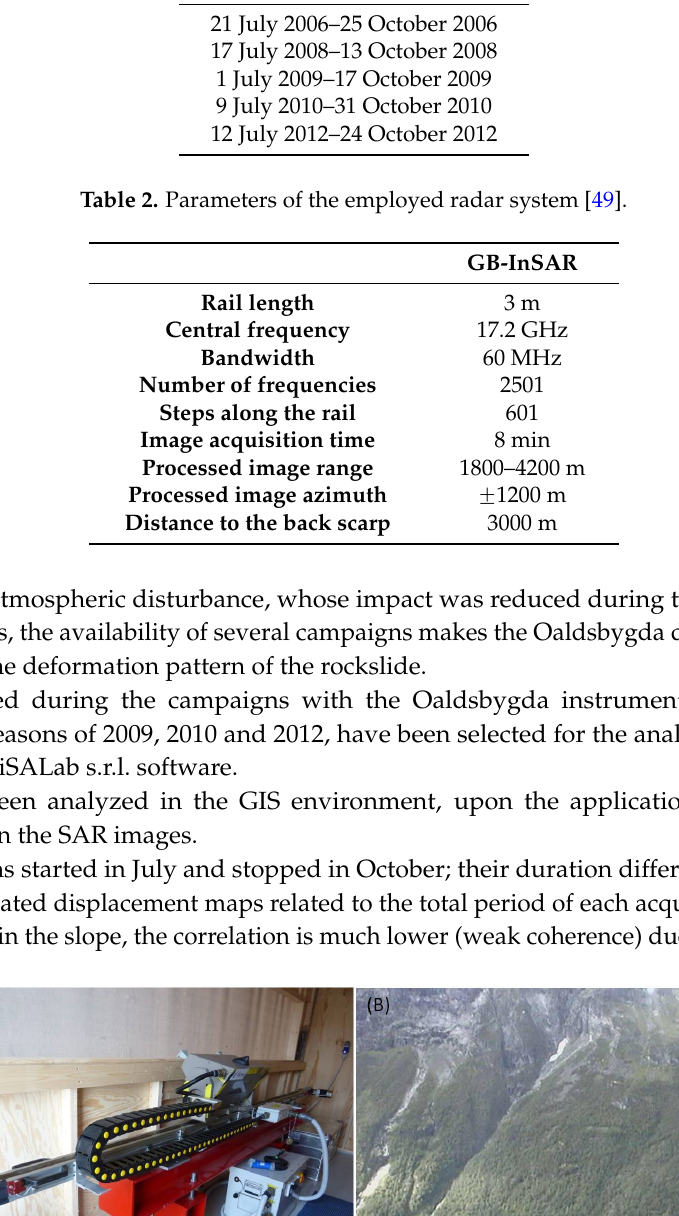
Table 1 . Dates of ground-based (GB)-InSAR campaigns.